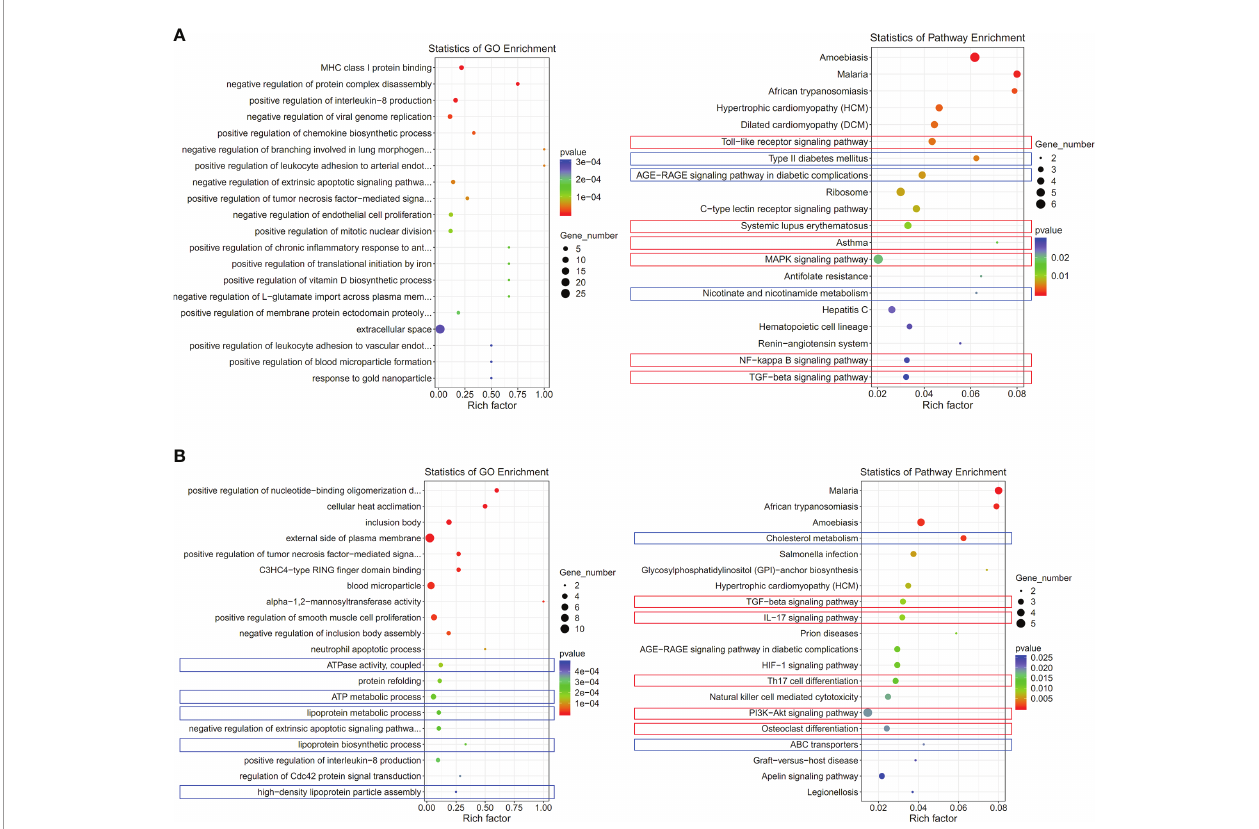
FIGURE 4 | Signi fi cantly altered pathways in CIA rats at different Nampt expression statues. (A) results of pathway enrichment analyses using differentially expressed genes between CIA rats at Nampt ++ status and normal healthy controls; (B) results of pathway enrichment analyses using differentially expressed genes between CIA rats at Nampt + status and normal healthy controls. The altered pathways related to in fl ammation and energy metabolism were indicated in red and blue,